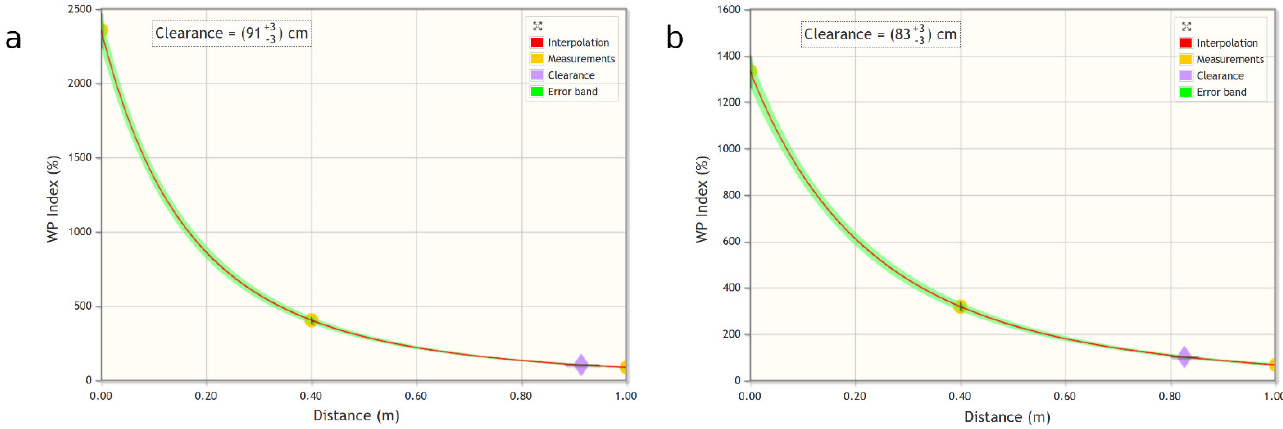
Figure 3. Interpolation of the B2 sequence at different distances and heights from the ground: ( a ) 100 cm from the ground ( b ) 160 cm from the ground.